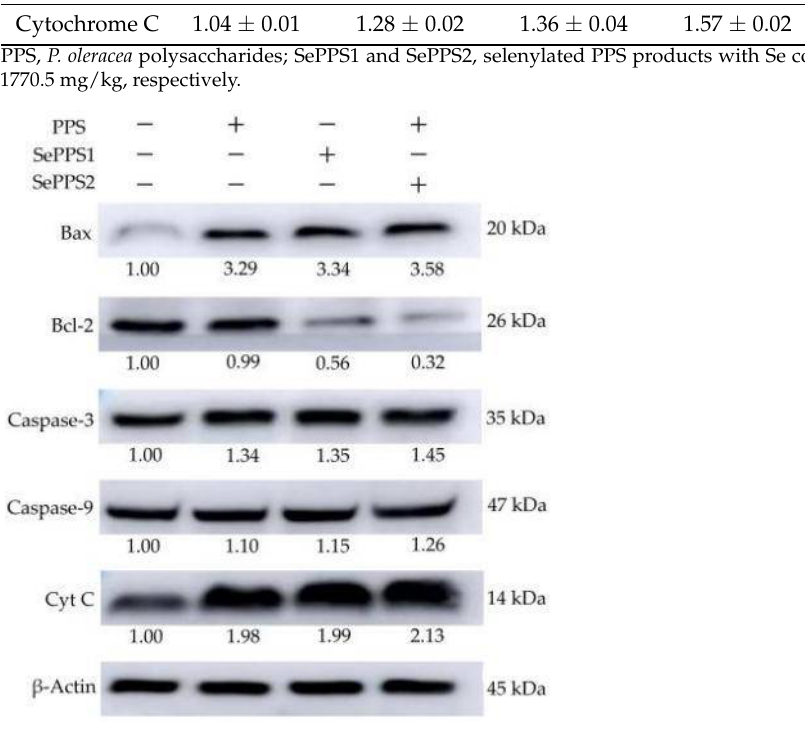
Figure 7. Effects of P. oleracea polysaccharides (PPS) and two selenylated PPS products (SePPS1 and SePPS2) on the expression of five protein targets in HCT-116 cells with a treatment time of 24 h. Cyt C, cytochrome C. The labeled values indicate expression changes in the targeted proteins.